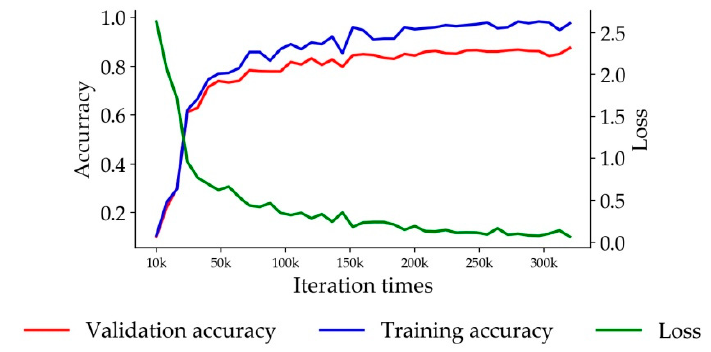
Figure 6. Model training accuracy curve, validation accuracy curve and loss curve.